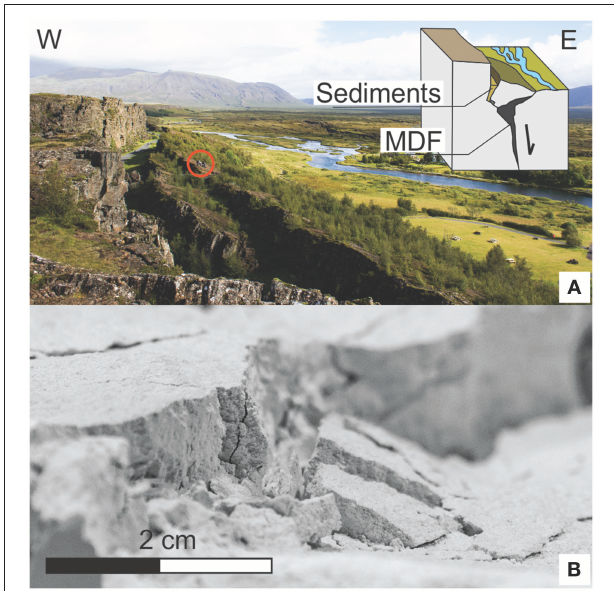
FIGURE 1 | Examples of massively dilatant faults in nature and experiment. (A) Thingvellir Fault in Iceland. For exact location see Figure 10 . Red circle shows four geologists for scale. Top right shows sketch of fault geometry. The river flows on the hangingwall. Between hangingwall and footwall Massively Dilatant Faults (MDF) develop, which may be several tens of meters wide. These open fractures may be partly filled with sediments, water, ice or lava flows. Close the surface tilted blocks can form. (B) Experiment in hemihydrate powder shows open fractures and tilted blocks similar to the geometries observed in the field. Quantitative mapping of the geometry of analog examples may provide insights on the kinematics and deep structure of the